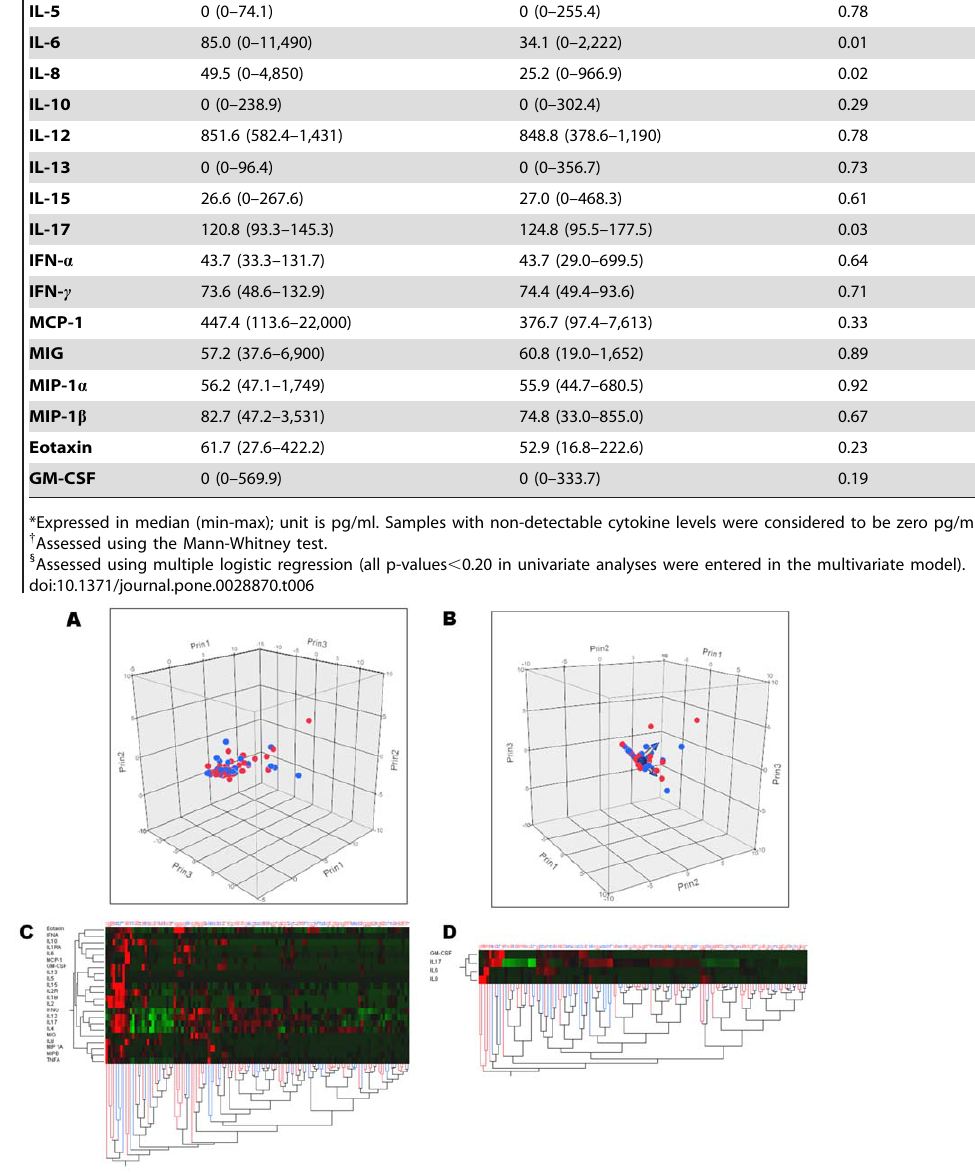
Figure 5. Principal component analysis and clustering of cytokine profiles in patients with (n=75) and without (n=51) bacterial infection. Patients with (red dots) and without (blue dots) bacterial infection are represented according to the first three components computed using principal component analysis of either all 22 cytokines (panel A), or a more limited profile using only IL-6, IL-8, IL-17 and GM-CSF (panel B). Hierarchical cluster analysis using all 22 cytokines measured (panel C) and the more limited profile (panel D) are also presented. The dendrogram at the bottom of panels C & D shows the clustering of patients with (red lines) and without (blues lines) bacterial infection, according to the cytokine profile selected (dendrodram at the left). The color map at the center indicates the cytokine levels for each patient (brightest green is lowest level and brightest red is highest level measured). Altogether, these analyses show that patients with bacterial infection cannot be distinguished from those without. doi:10.1371/journal.pone.0028870.g005 PLoS ONE |